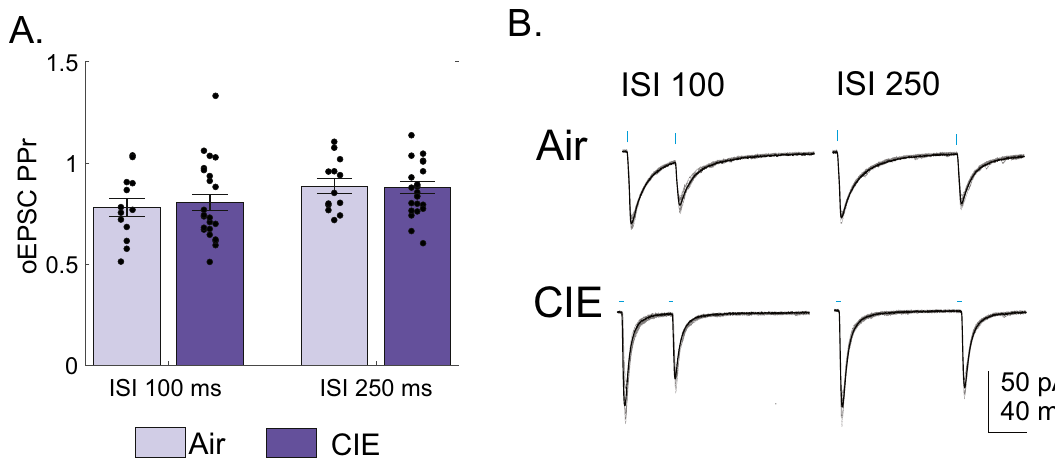
Figure 3. Presynaptic release probability of BLA-vSub oEPSCs is not altered in CIE rats. ( A ) PPr of oEPSCs at 100 and 250 ms ISI are unchanged in vSub neurons of Air and CIE rats. ( B ) Representative traces of oEPSC evoked at 100 (left column) and 250 (right column) ms ISIs in vSub neurons of Air (upper traces) and CIE (lower traces) rats. In representative traces individual inputs are shown by thin lines while the average response amplitude is illustrated by a thicker overlaid line. Blue bars above figures illustrate onset and duration of optical stimulation. Errors are reported as ±